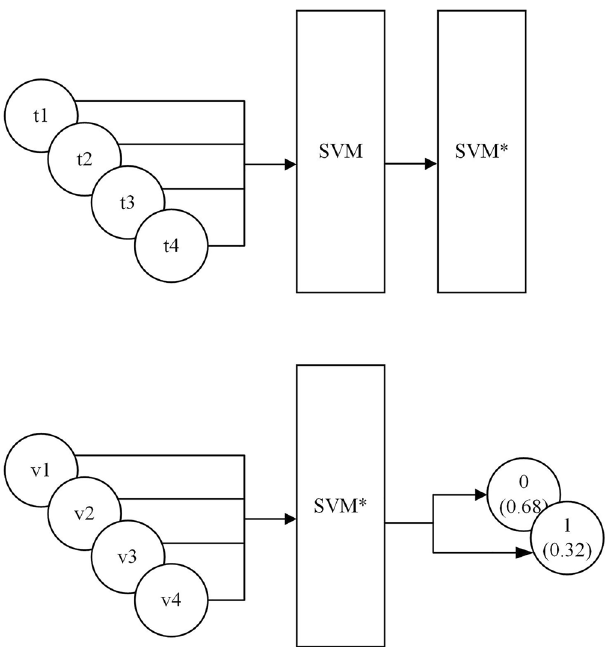
Figure 4. Schematic of the inputs and outputs of the